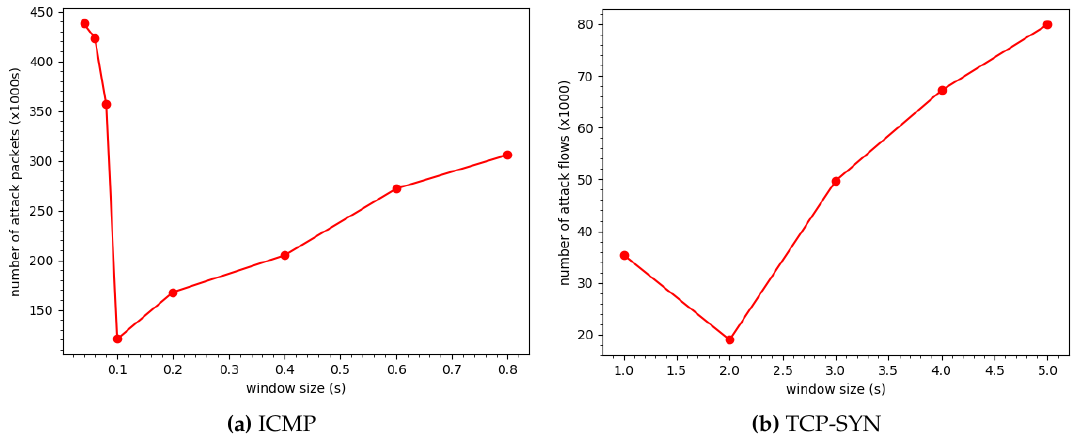
Figure 6. Performance of the system for each monitoring time window value in ( a ) ICMP flood